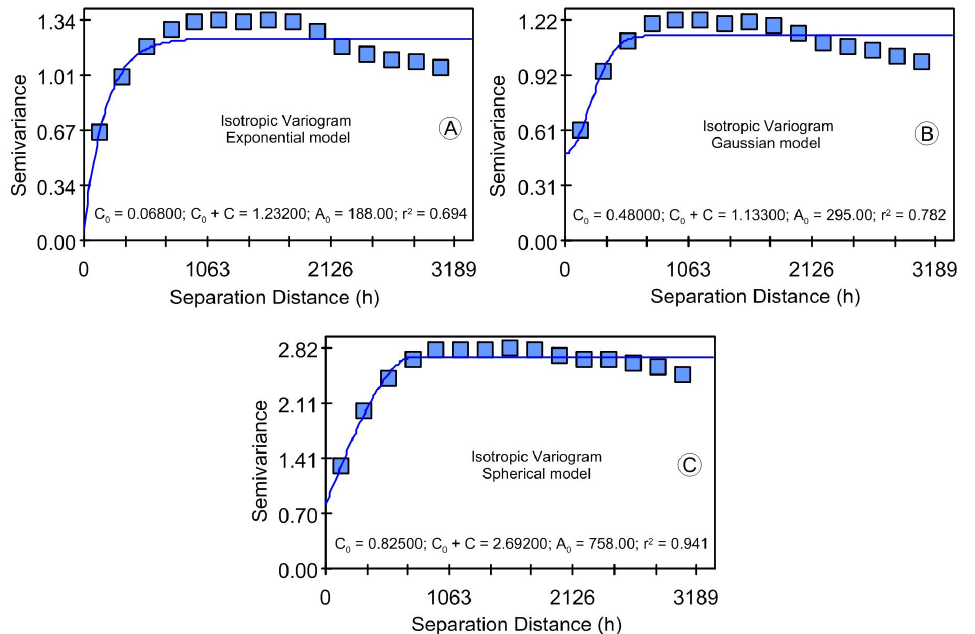
Figure 4. Semi-variograms used for the kriging of the maximum UHI intensities at 20:30 ( A ); 21:00 ( B ); and 21:30 ( C ).